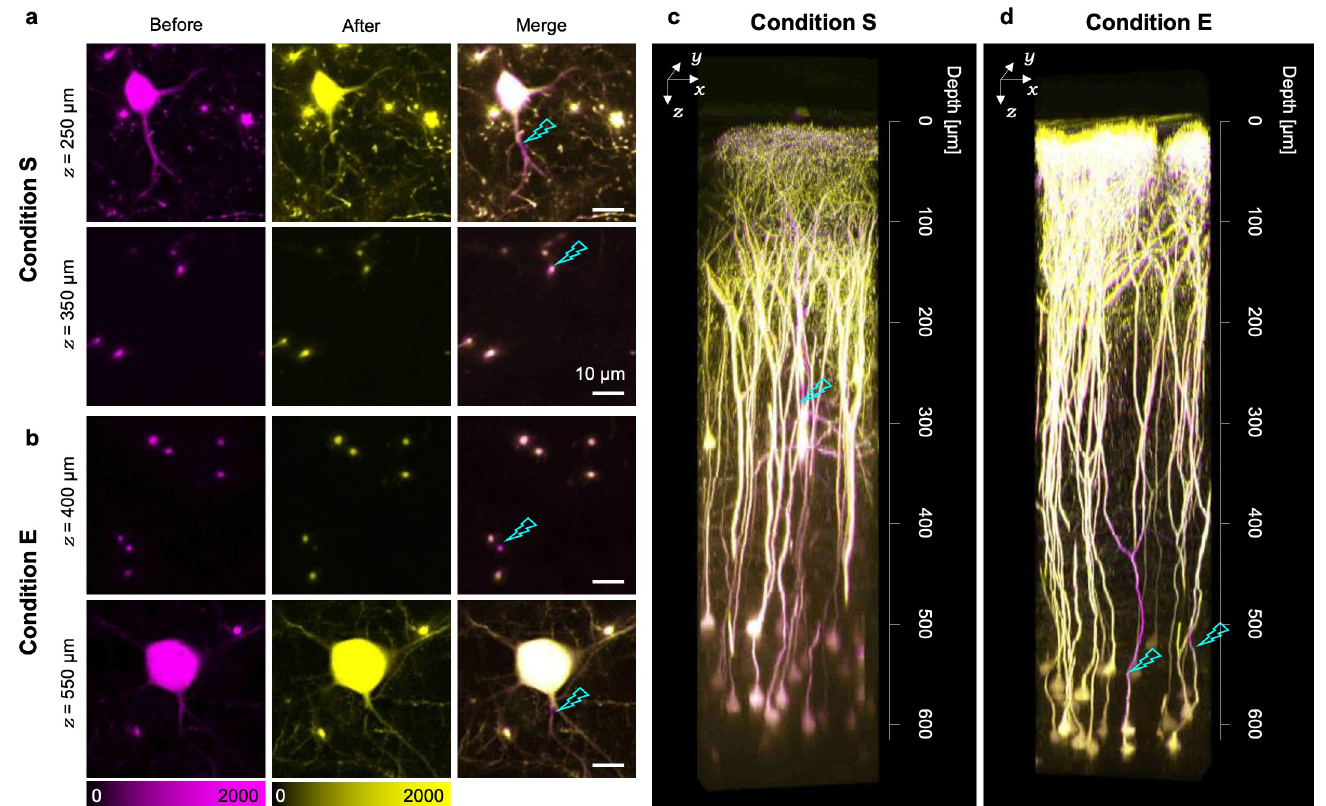
Fig 7. Two-photon focal laser ablation in cortical layer V under condition E. (a, b) Fluorescence images obtained before and after the laser ablation under (a) condition S and (b) condition E. The right panels show the merged images. All scale bars represent 10 μ m. (c, d) 3D reconstructed images merged before focal laser irradiation and after 1 day under (c) condition S and (d) condition E. The magenta regions represent the sites disrupted by the focal laser ablation, and the cyan thunders represent the sites irradiated with laser light.